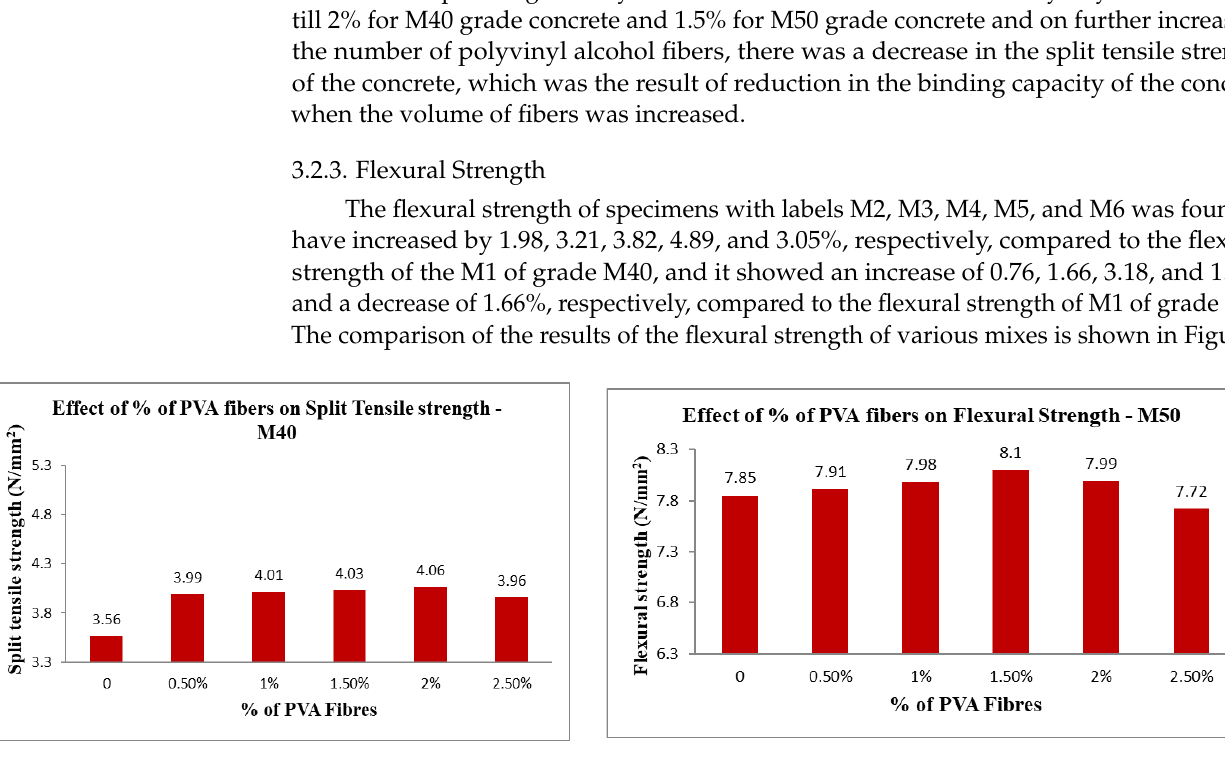
Figure 6. Comparison of flexure test results on expansive cement concrete specimen.